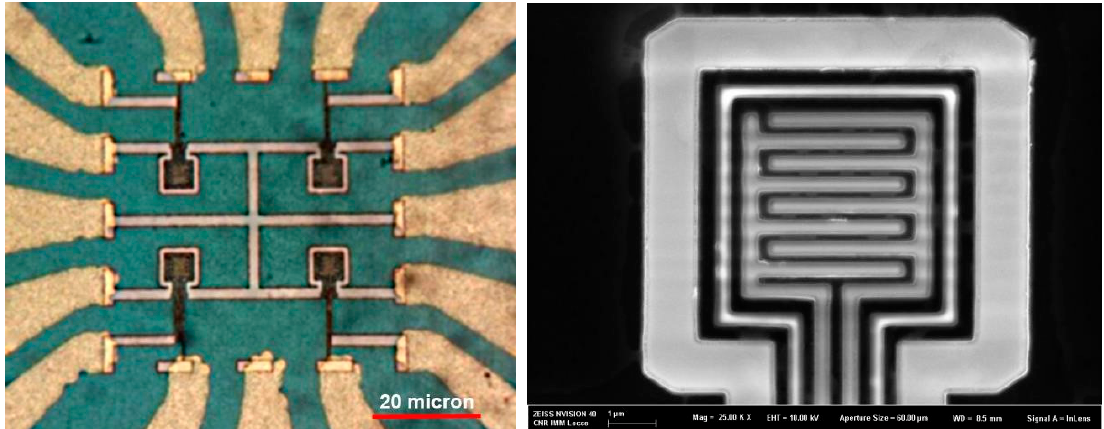
Figure 1. Fabricated MOX sensor array onto silicon substrate ( left ), SEM image of the single nanogap device with embedded heater and thermometer ( right